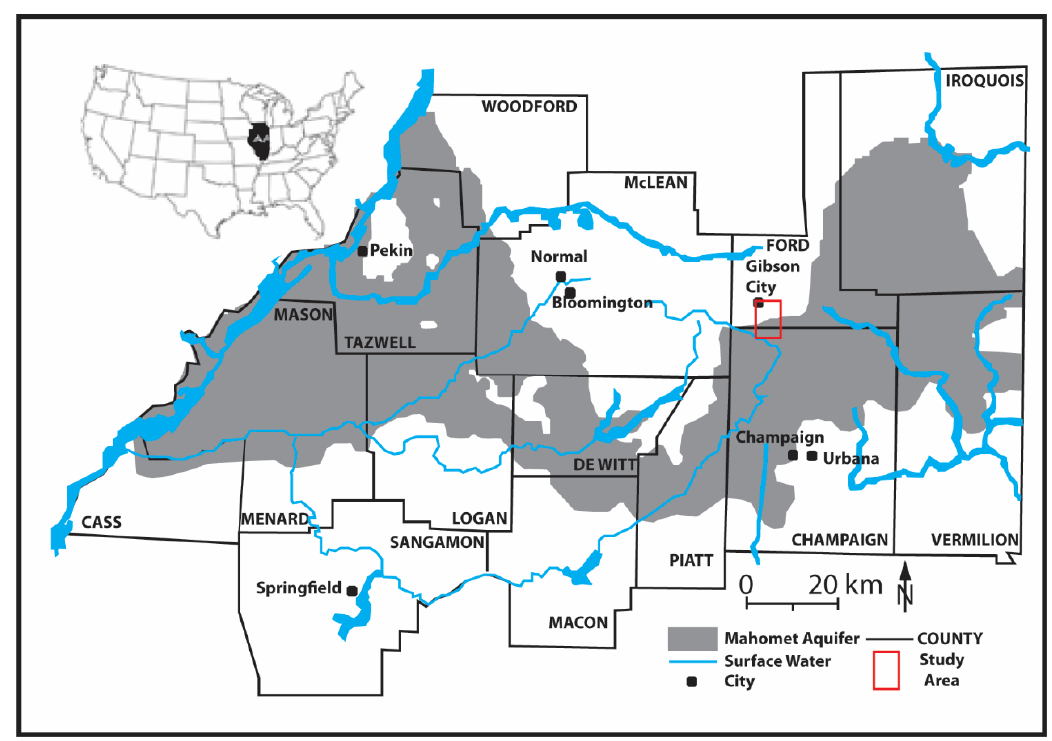
Figure 1. Map of the Mahomet Aquifer (gray area) in east-central Illinois, USA. Mapping area is highlighted by red box. Figure modified from [45] .